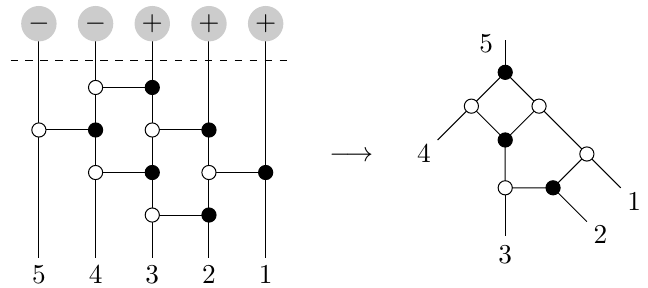
Figure 4 . On-shell diagram construction via BCFW bridges for A 5